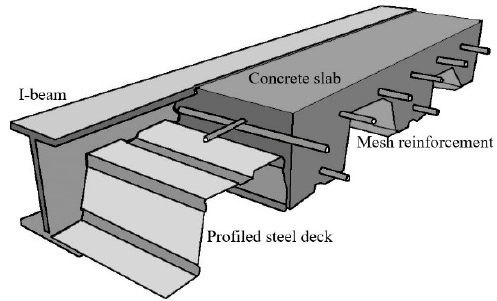
Figure 1. Slimflor beam incorporated with profiled steel deck.